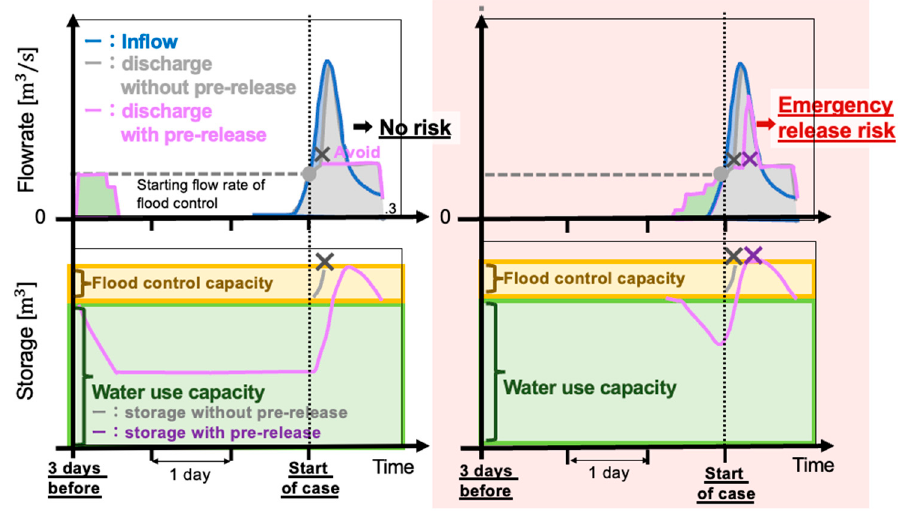
Figure 6. Pre-release simulation classi fi ed into no risk ( left ) and emergency release risk ( right ).